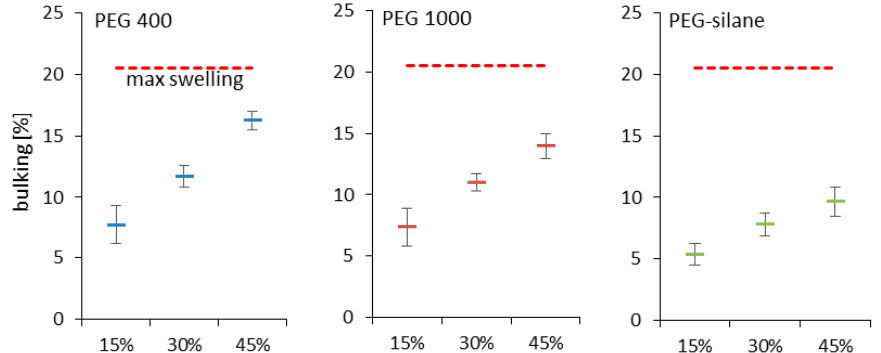
Figure 5. Transversal bulking of oak wood samples with different loadings, dry after impregnation. Maximum swelling of untreated oak wood displayed as dotted line. Standard deviation given in whiskers. Different modification agent concentrations result in significantly different bulking values.